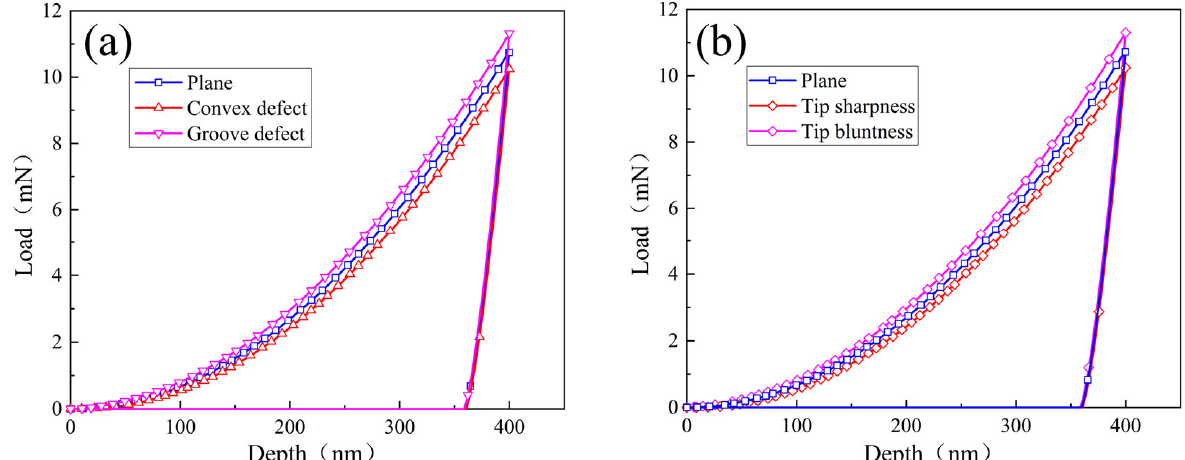
Figure 8. Load–depth curves: ( a ) surface defect; ( b ) indenter tip irregularity.